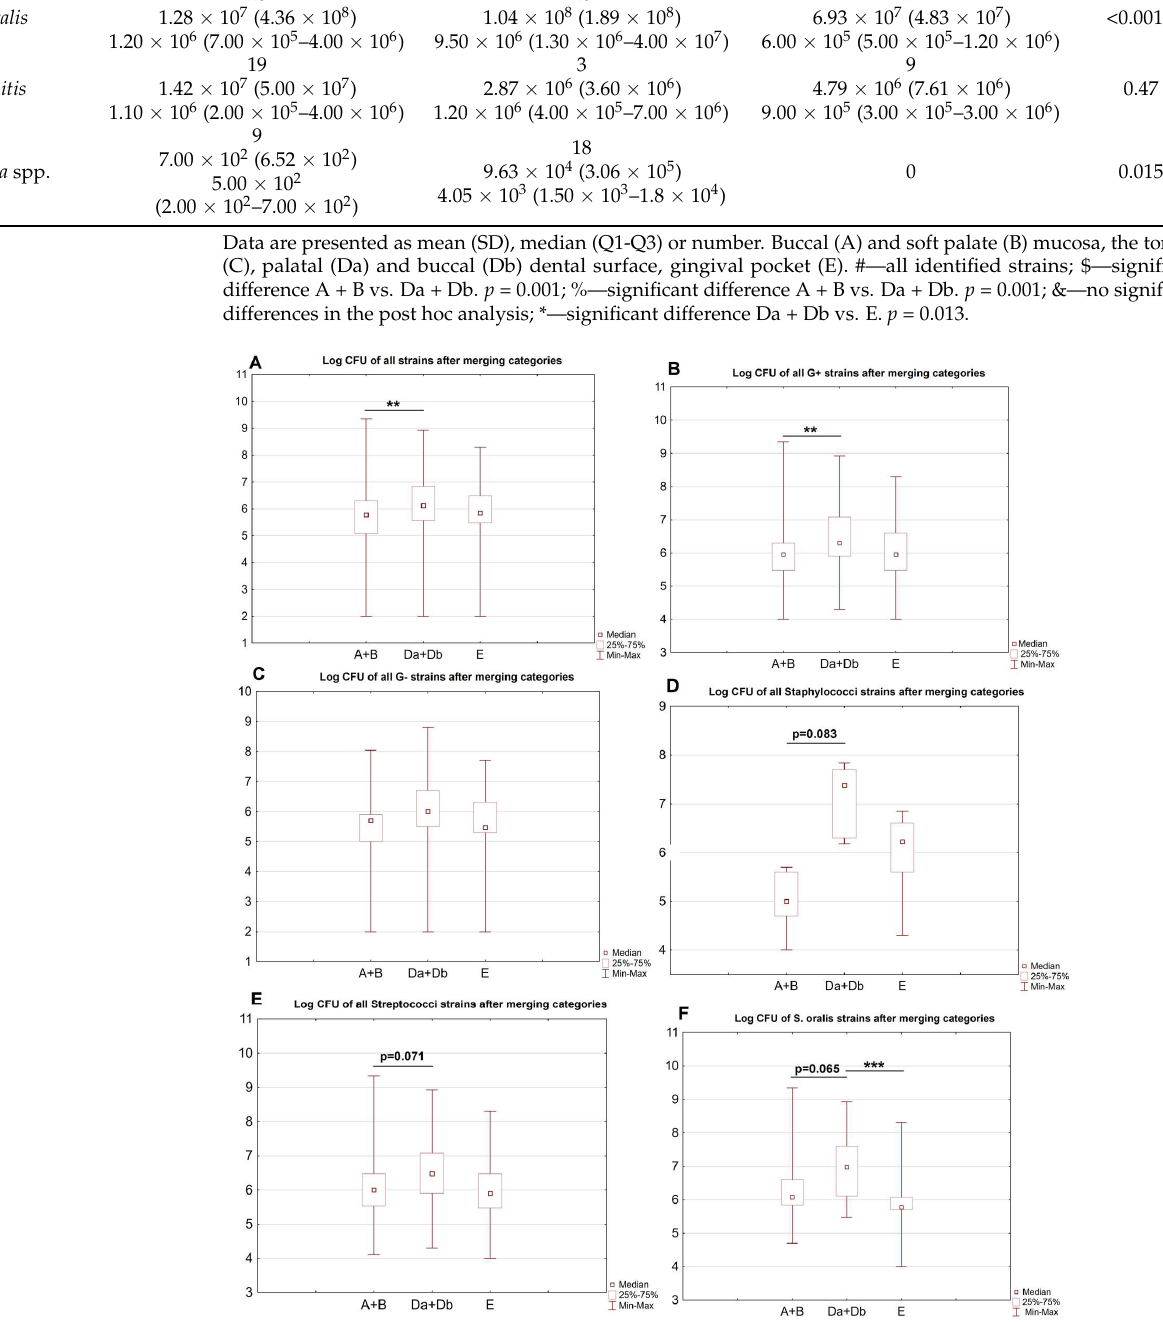
Figure 4. ( A – F ) Comparisons of sites A + B, Da + Db and E. Log CFU of all strains (overall, A), G+ (B), G − ( C ), Staphylococci ( D ), Streptococci ( E ) and S. oralis ( F ) strains after merging categories. Selected borderline significant differences are presented. ** p < 0.01; *** p <